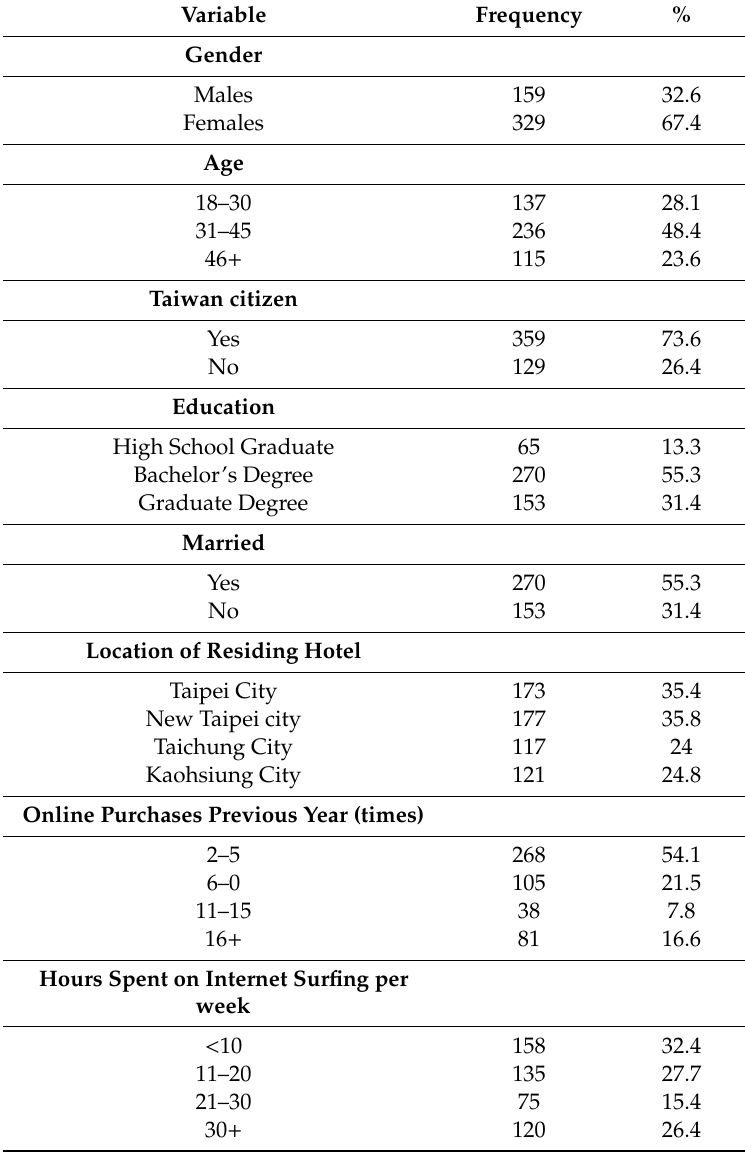
Table 1. Demographic characteristics of the respondents (N =